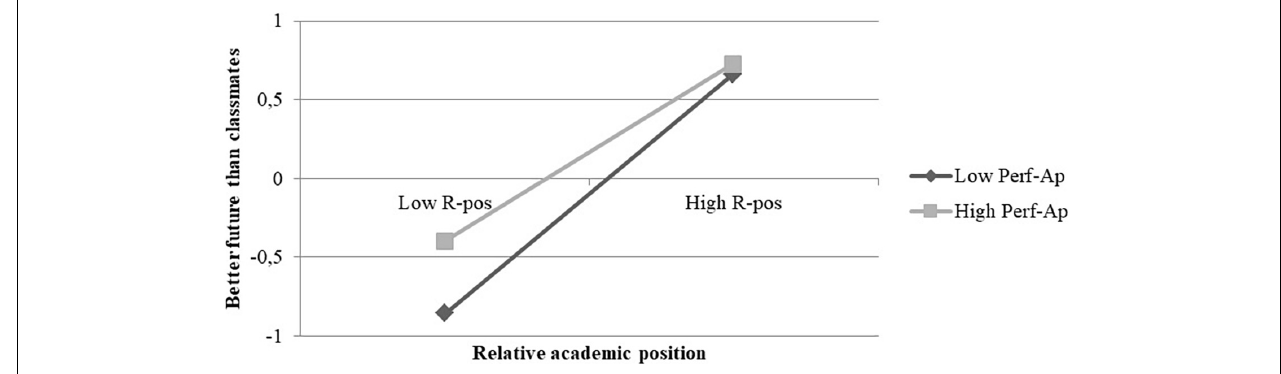
FIGURE 3 | Conditional effects of perceived relative academic position (R-Pos) on better future at different levels of performance-approach